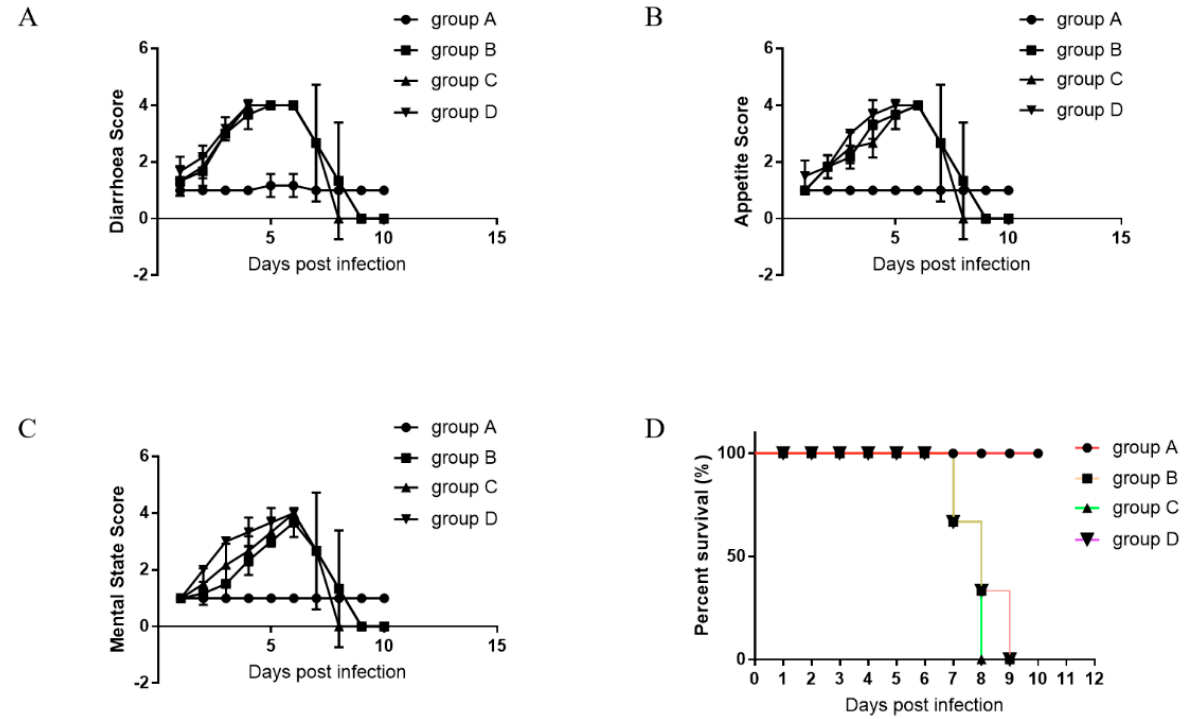
Figure 8. Oral administration of anti-PEDV mAb-2 inhibits infection in piglets. ( A-C ) Symptom scores for diarrhea, appetite and mental state respectively. ( D ) Percent survival of the tested pig- lets.